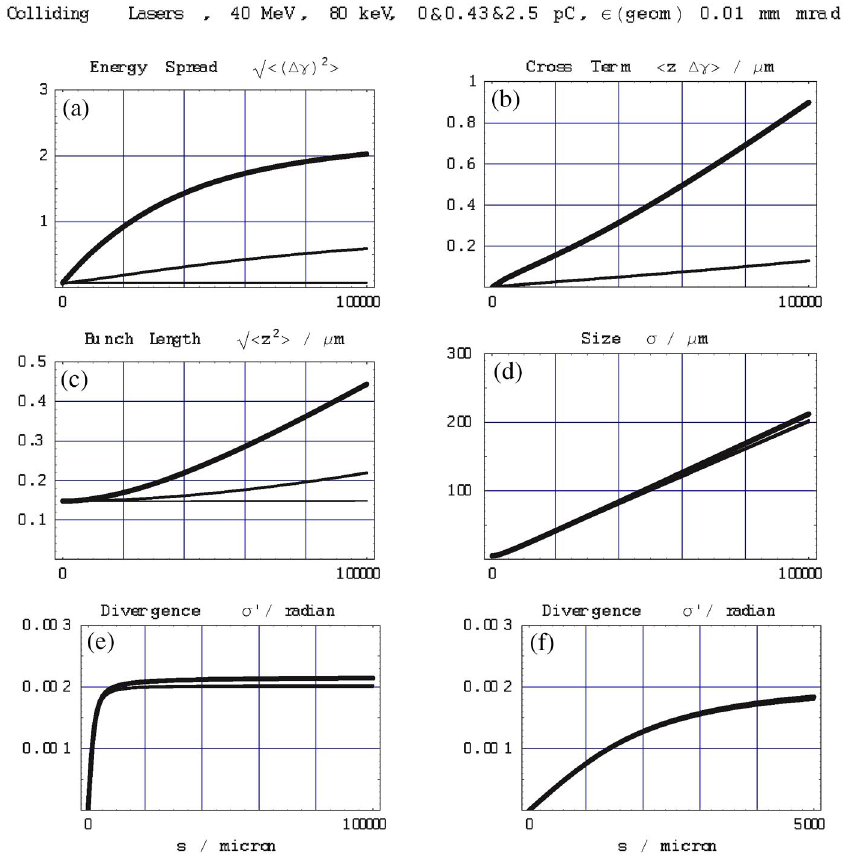
FIG. 4. (Color) Longitudinal and transverse phase space dynamics for an example of bunches produced by ‘‘colliding’’ lasers [23] for three charges of 0, 0.43, and 2.53 pC per micro (plasma) bucket. The curves are calculated for general electron bunch parameters of E 40 MeV , (cid:16) E (cid:3) 80 keV , bunch length 2 (cid:3) 1 fsec ( 0 : 3 (cid:4) m ) per 3 fsec plasma bucket, and initial divergence (cid:2) 0 (cid:6) 0 (cid:7) (cid:3) 0 . For ease of comparison we used an initial spot size of (cid:2) (cid:6) 0 (cid:7) (cid:3) 5 (cid:4) m , although the simulations had to use a larger (cid:2) (cid:6) 0 (cid:7) (cid:3) 15 (cid:4) m for the ‘‘high’’ charge case to get sufficient charge. The curves are for charges of 0, 0.43, and 2.53 pC, respectively, and show marked differences only for the longitudinal phase space. Because of the detrimental effect of energy spread on the emittance early rf capture might be important for a practical